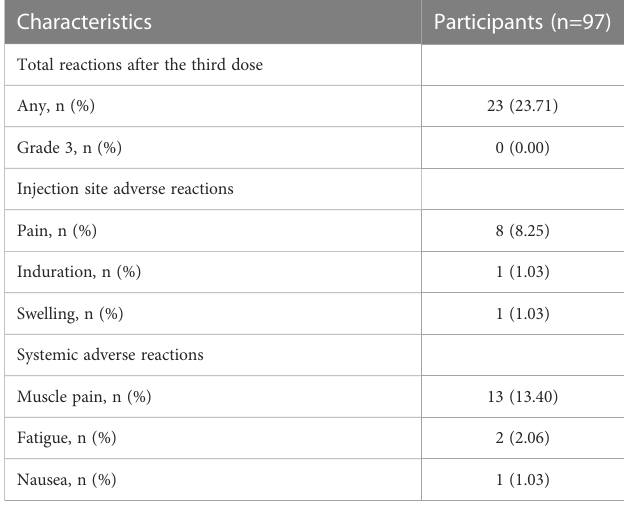
TABLE 2 Adverse reactions occurring within 7 days after the third dose in participants. Characteristics